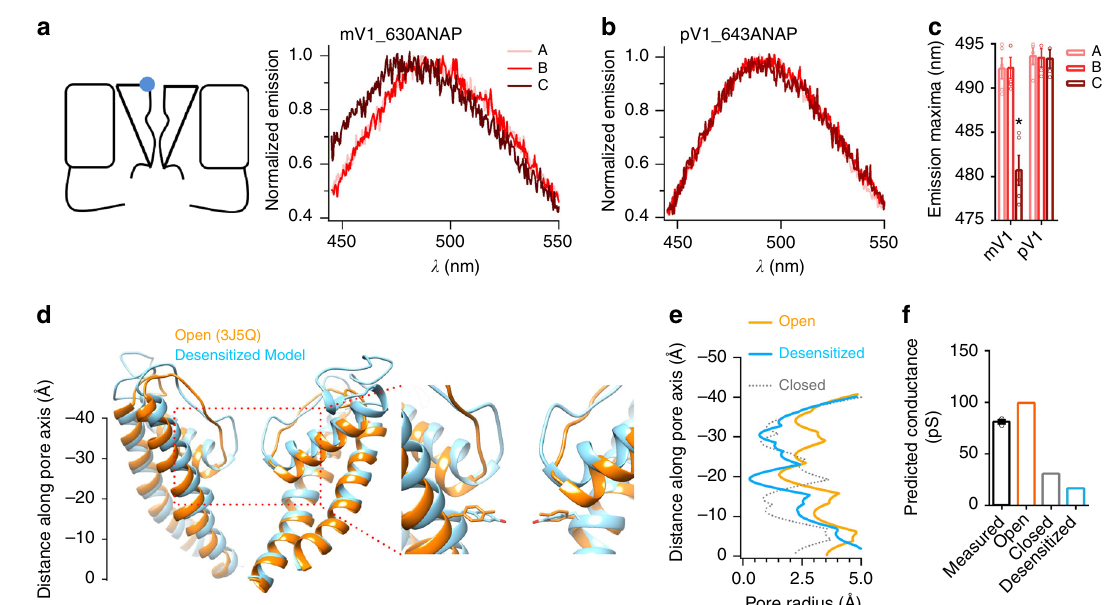
Fig. 4 Dh transition leads constriction of selective fi lter. a A schematic diagram showing the fl uorescence-labeled mV1 and pV1 (left panel). Molecular dynamics simulations of ANAP-labeled mV1 (mV1_630ANAP) at points A, B, and C during electrophysiological recording shown in Fig. 3a. b Molecular dynamics simulations of ANAP-labeled pV1 (pV1_643ANAP) at points A, B, and C during electrophysiological recording shown in Fig. 3c. c Summary of the emission maxima changes of ANAP labeled in mV1 ( n = 5) and pV1 ( n = 4), two-sided t -test: * p < 0.01. d Structural alignment of TRPV1 channel in the open state (orange, PDB ID: 3J5Q) and our model of the desensitized state (blue). The selectivity fi lter and the Y671 residue exhibited discernable conformational rearrangements between these two states (dashed box in red). e Distribution of pore radii in the cryo-EM-derived open state (3J5Q) (line in orange), our modeled desensitized state (line in blue), and the closed state (3J5P) (line in gray). Pore radii were calculated by the HOLE program 50 . f Conductance of TRPV1 in different states predicted by the HOLE program. Our desensitized state model (bar in blue) was predicted to have similar conductance as the closed state (3J5P) (bar in gray). The open state (3J5Q) (bar in orange) shows a predicted conductance close to our experimentally measured values 55 . Data are mean ± SEM. Source data are provided as a Source data fi